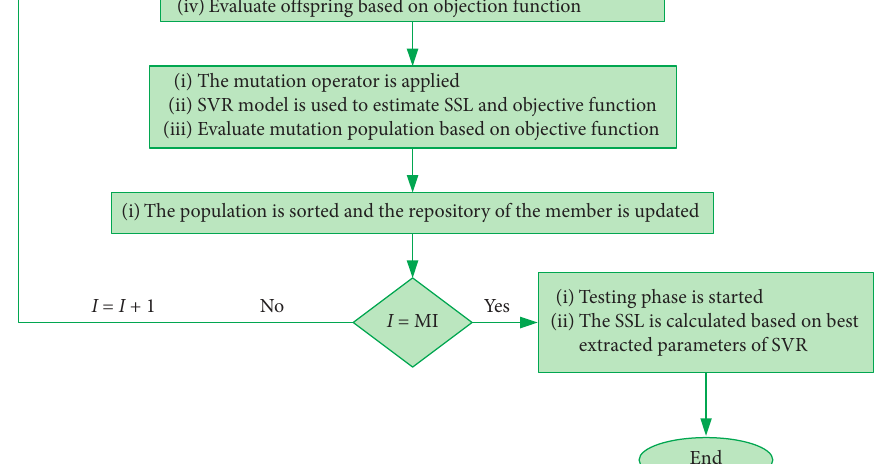
Figure 3: Algorithm of the SVR-GA